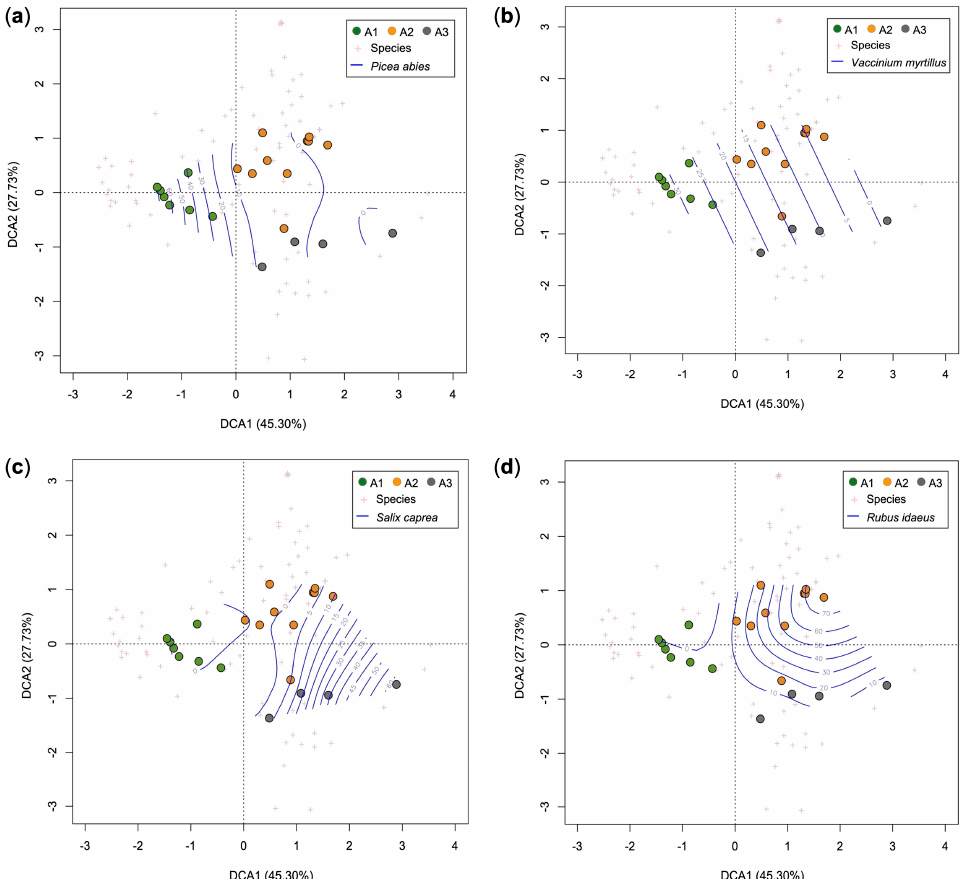
Figure 5. DCA biplots of phytosociological relev é s (dots) overlapped with plant cover contour lines (blue lines with percentage of plant cover) of some diagnostic species of each cluster: Picea abies ( a ), Vaccinium myrtillus ( b ), Salix caprea ( c ) and Rubus idaeus ( d ). Key: A1, Picea abies forest; A2, Rubetum idaei ; A3, Piceo abietis-Sorbetum aucupariae